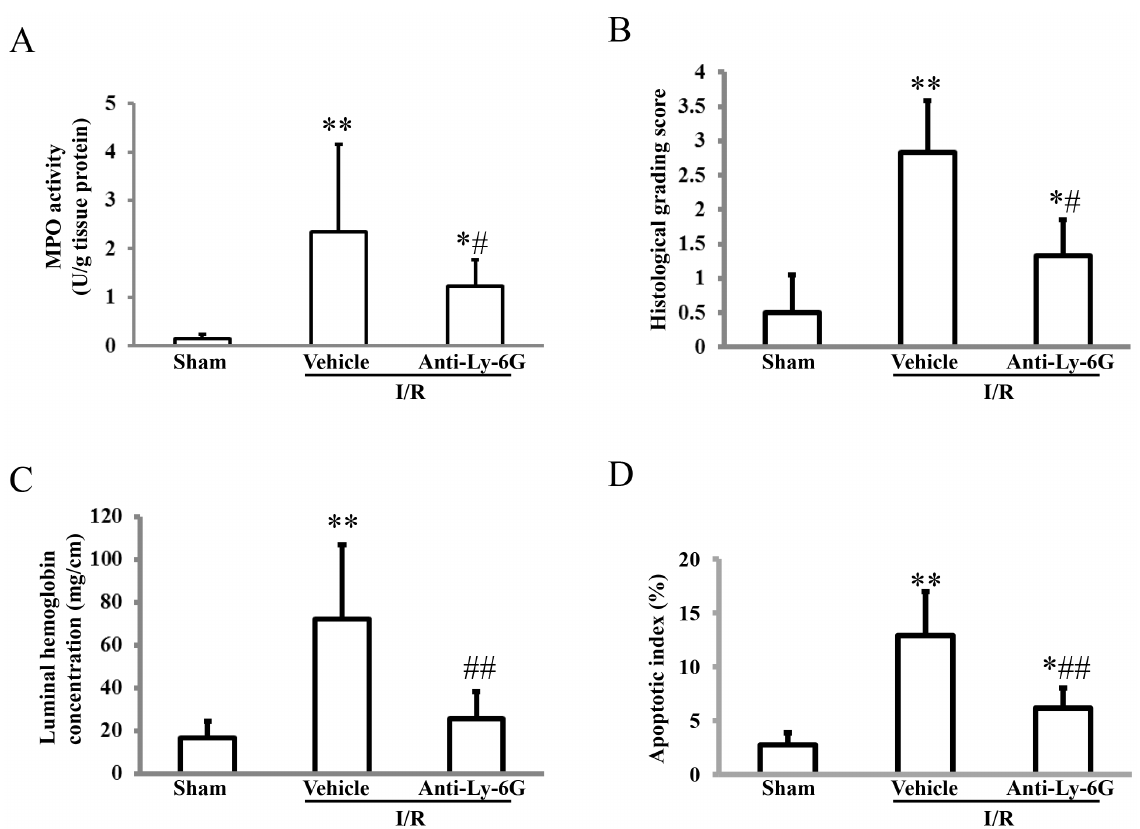
Figure 3. Roles of neutrophils in the intestinal ischemia-reperfusion injury. Wild-type mice that were intraperitoneally administered either rat anti-mouse Ly-6G antibodies or the vehicle (control rat IgG2a) 24 h before were subjected to 45 min of ischemia followed by 60 min of reperfusion. After removal of the small intestine, an assay of myeloperoxidase (MPO) activity (a marker of neutrophil infiltration, A), assessment of the intestinal injury by using the histological grading system (B), measuring the luminal hemoglobin concentration (C), and counting apoptotic epithelial cells with an antibody to ssDNA (D) were each performed. Each column represents the mean 6 SD. N=6–9. ** P , 0.01, * P , 0.05 vs mice with sham operation, ## P , 0.01, # P , 0.05 vs mice that were subjected to the ischemia-reperfusion injury and given the vehicle. I/R; ischemia/reperfusion.